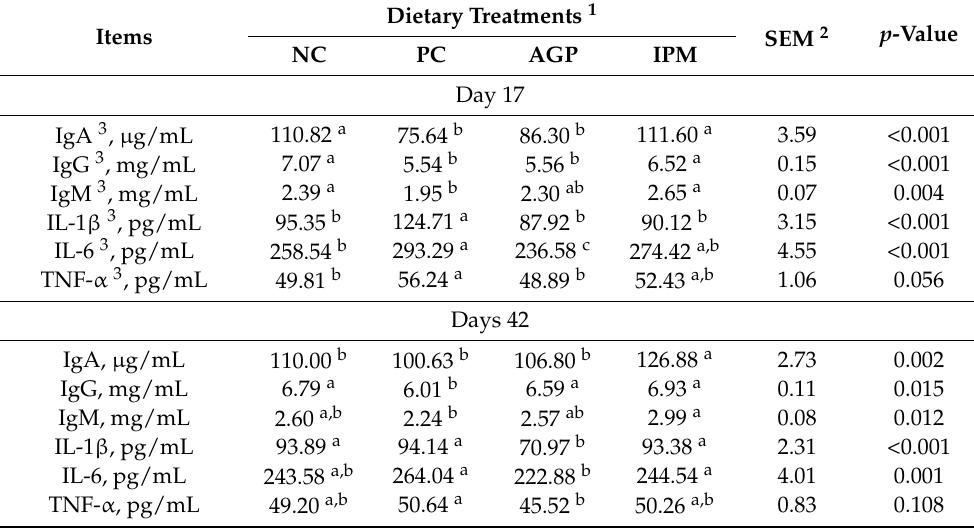
Table 4. Effect of dietary treatments on serum immune indices of weaned pigs challenged with E. coli K88. Items